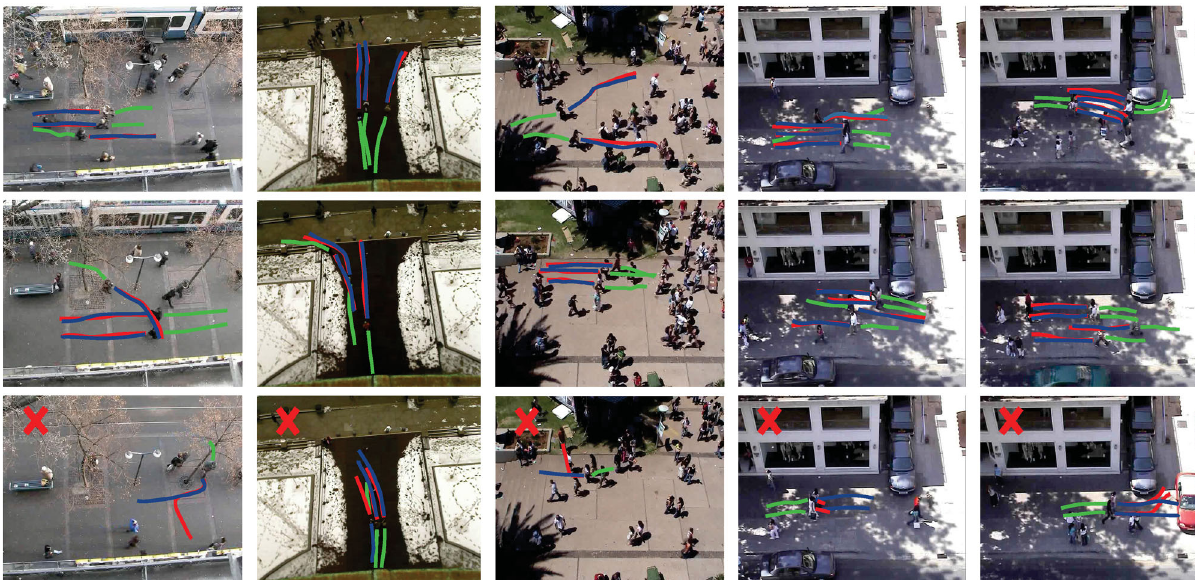
Fig. 5 Example results of our method. Given observed trajectories for the past 8 time steps (green), our method predicts the trajectories for 12 future time steps (blue), and compares them with the ground truth trajectories (red). Left to right: results for ETH, HOTEL, UNIV, ZARA1, and ZARA2. Above, center: representative examples where our method successfully predicts trajectories with small errors. Below: failure